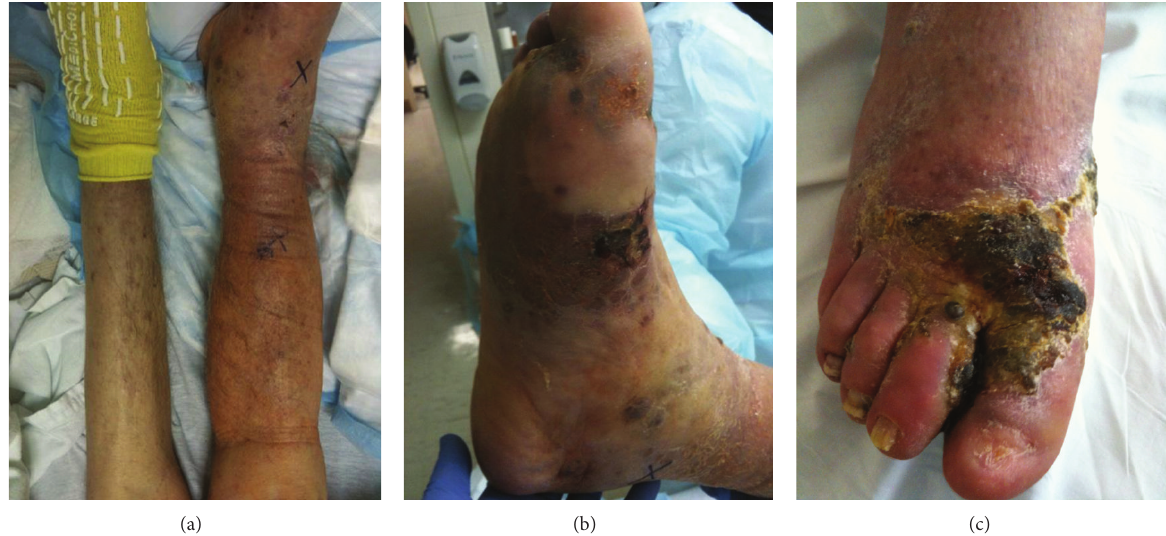
Figure 1: (a) Patient’s right lower leg is seen here demonstrating the lymphedema compared to the opposite left leg. (b) and (c) Picture of the patient’s right foot showing the blue/purple KS skin lesions as well as areas of